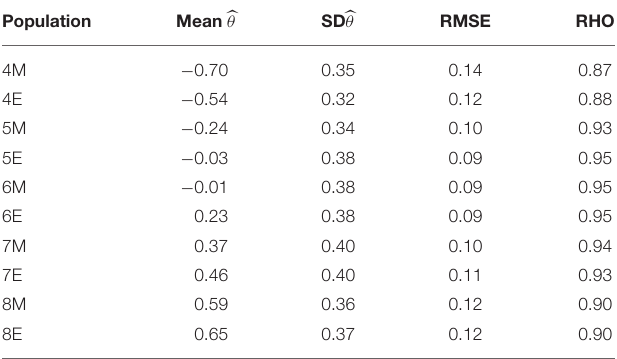
TABLE 4 | Test length (tl) in the spelling CAT with percentages of population with test length. Population